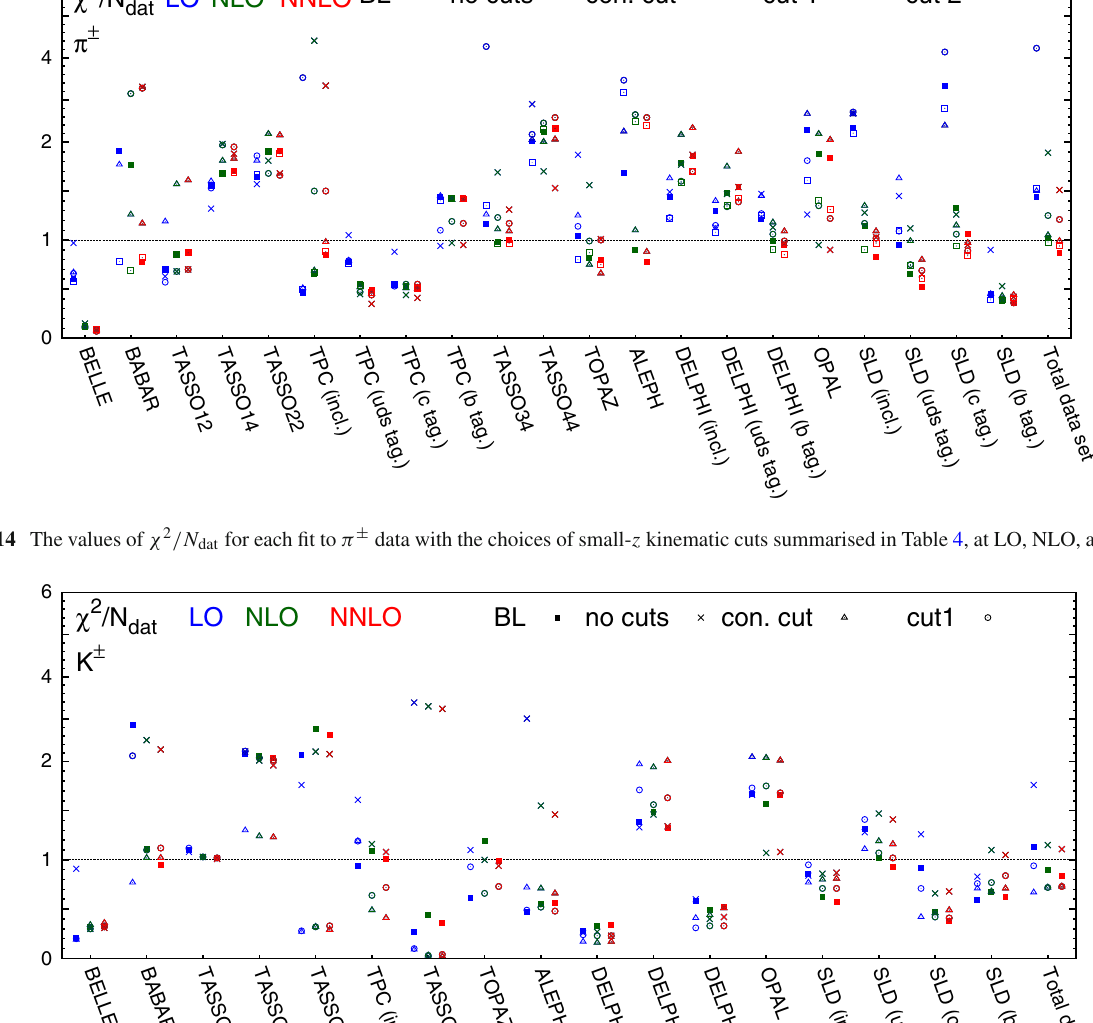
Fig. 15 Same as Fig. 14, but for K ±